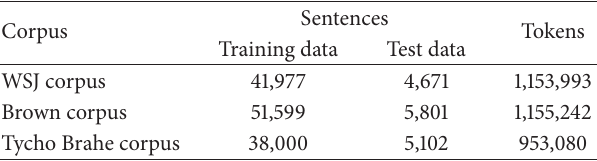
Table 6: Performance of systems on different languages of Europarl corpus.